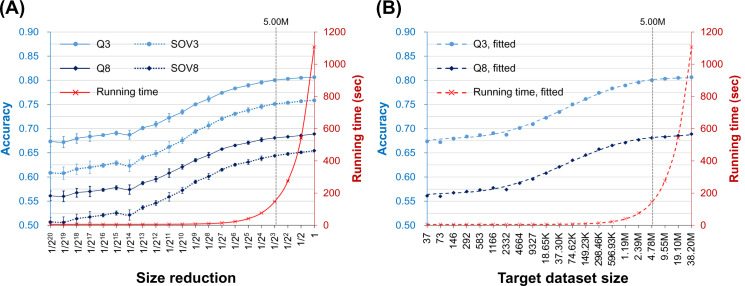
The average time cost and accuracy of the assessed secondary structure prediction methods as the target dataset size reduces.(A) The curves of actual experimental results averaged over seven SSP methods. The meanings of the axes of this plot are the same as those of Fig 1, but the scale of the vertical axis of accuracy (blue) is adjusted to start from 0.5 to make visible the standard deviations, which were obtained by ten repeats of random sampling test for each assessed method. Supporting our hypothesis, the decrease in time cost was much faster than that in accuracy. Provided that the target dataset sampled from the UniRef90-2015 was larger than ~5 million sequences (indicated by the dotted vertical line), the decrease in accuracy was minor. (B) The curves of fitted Q3 and Q8 accuracies. The horizontal axis indicates the number of proteins in the PSSM target dataset (M: million, K: thousand). The points of accuracies are drawn by the actual data, but the curves are made by Eqs (2) and (3), showing that those equations fit well with the experimental results.